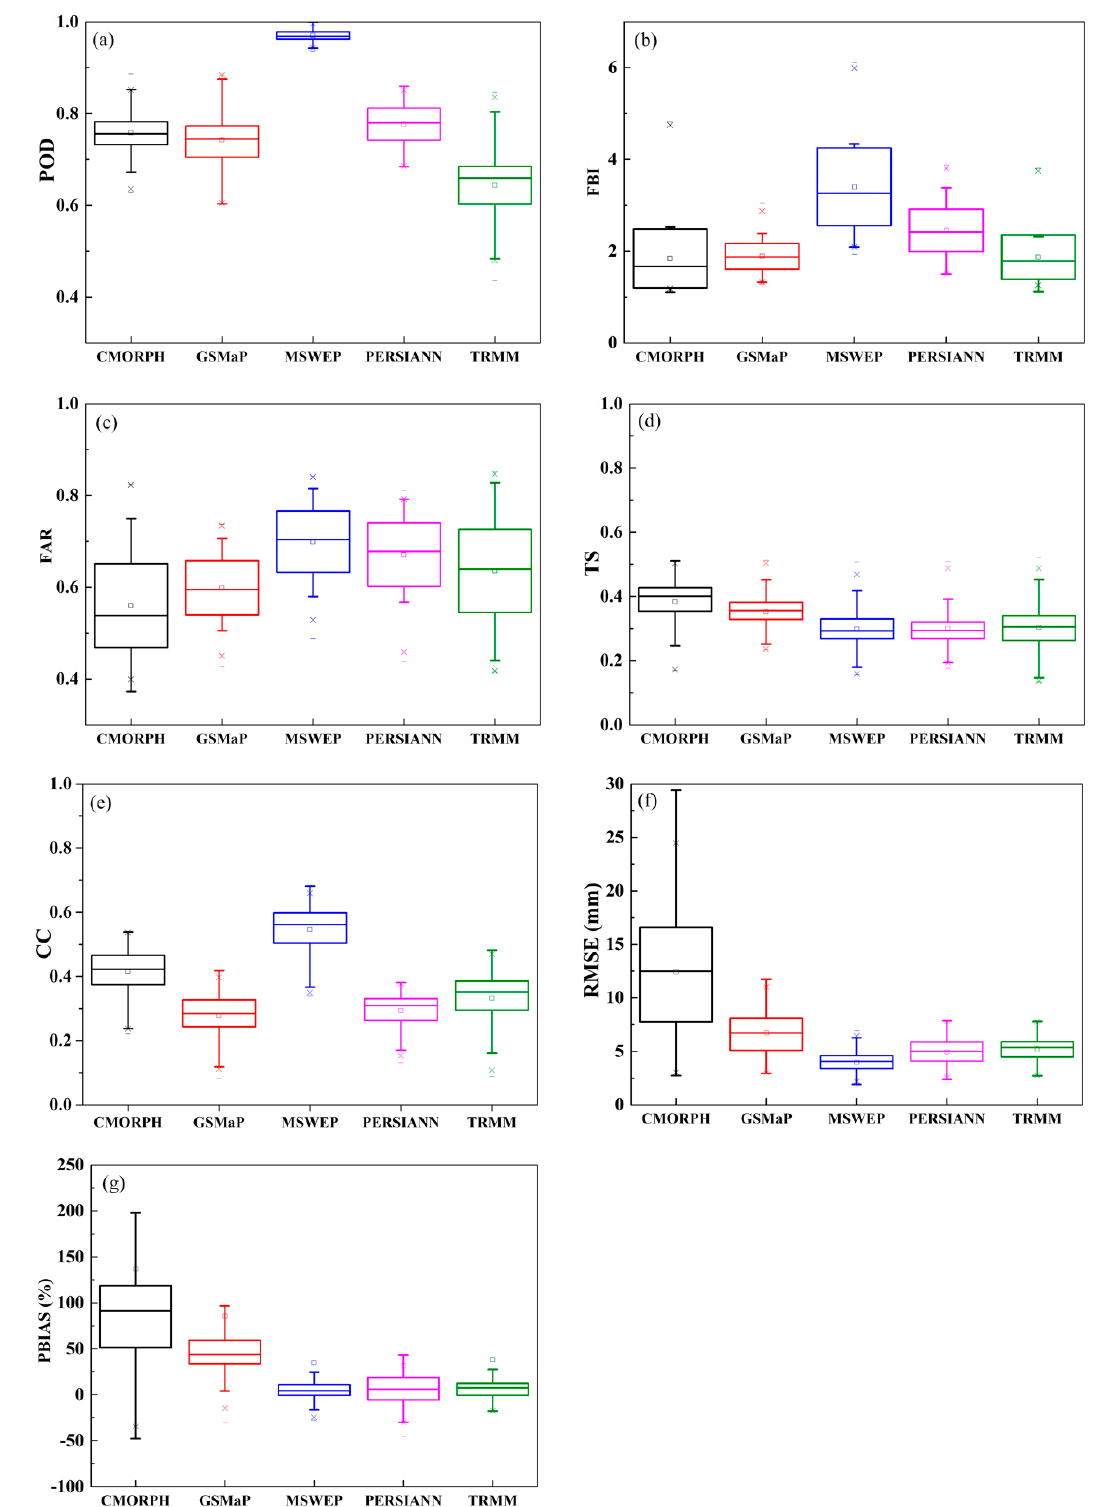
Figure 6. Detective ability of precipitation event: ( a ) POD, ( b ) FBI, ( c ) FAR, ( d ) TS and detective ability of precipitation: ( e ) correlation coefficient, ( f ) root mean square error, ( g ) PBIAS. POD is probability of detection, FBI is the frequency bias index, FAR is false alarm ratio, CC is correlation coefficient, RMSE is root mean square error, PBIAS is bias.